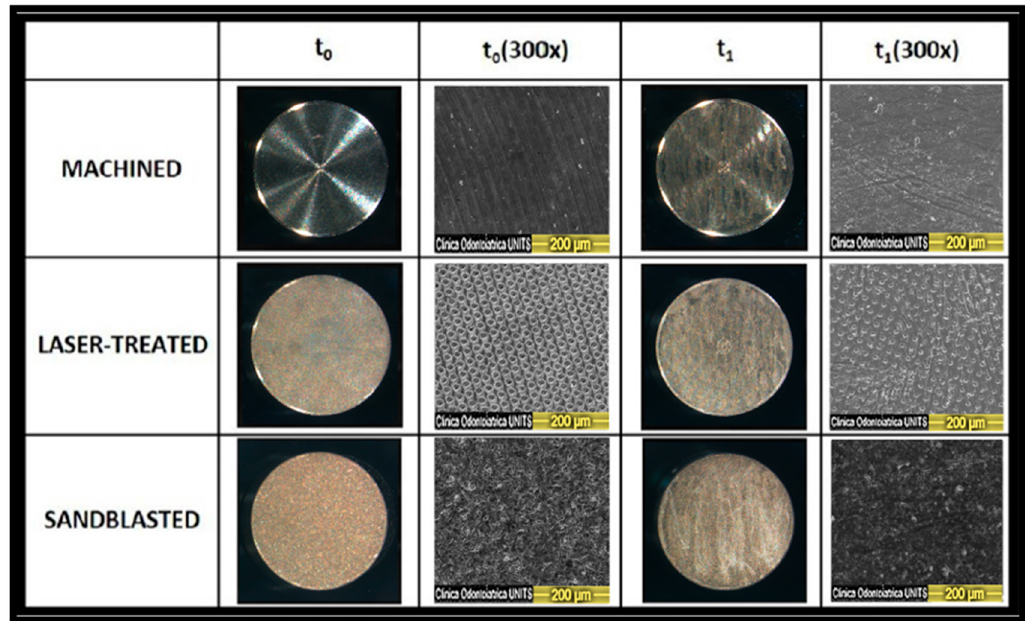
Figure 2. 3× and 300× magnification of brand new titanium surfaces before instrumentation (t 0 ) and after instrumentation (t 1 ). 300× magnification was obtained with a scanning electron microscope (SEM) (Quanta 250 SEM ® , FEI Company ® , Hillsboro, OR, USA). Considering the laser-treated 300× micrographs, it seems that this surface is the one that maintains its “grid structure” characterized by regular roughness.